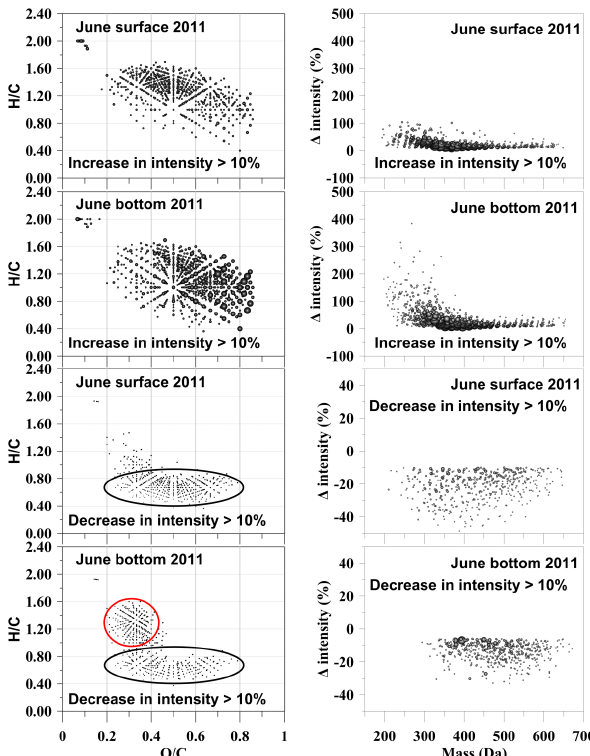
Fig. 8. Photochemically induced changes in the molecular composi- tion of a boreal lake SPE-DOM at the surface and bottom in summer and its associated increase in intensity of mass peaks that showed more than 10% change and a decrease of more than 10%, respec- tively. Results are illustrated using van Krevelen diagrams and dia- grams where the relative change in intensity is plotted against mass. Note: the bubble size in the van Krevelen diagrams correspond to the relative intensity change after irradiation, whereas the bubble size in the mass diagram corresponds to relative abundance of a mass peak; the red circle highlights the completely photo-degraded, more saturated DOM component during spring time sunlight expo- sure, whereas the black circle indicates slow photo-degrading, un- saturated and presumably aromatic DOM.